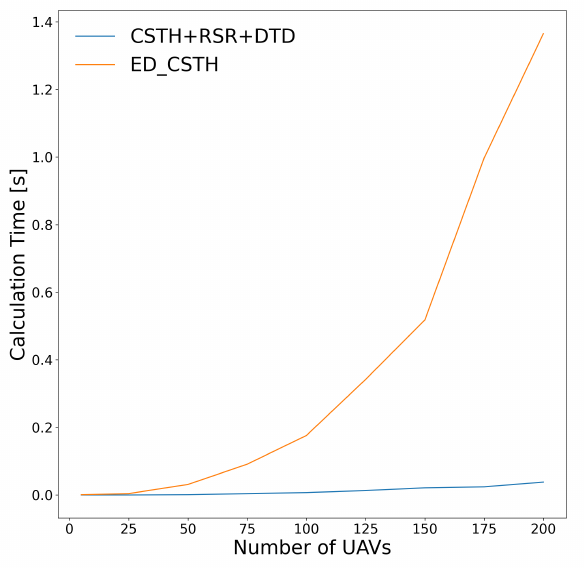
Figure 20. Calculation time in matrix